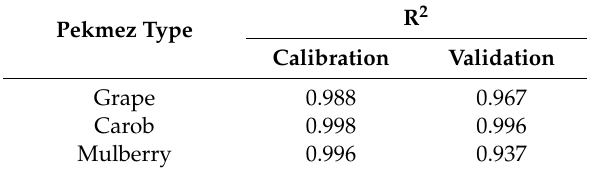
Table 2. R 2 values of calibration and validation curves for grape, carob and mulberry pekmez